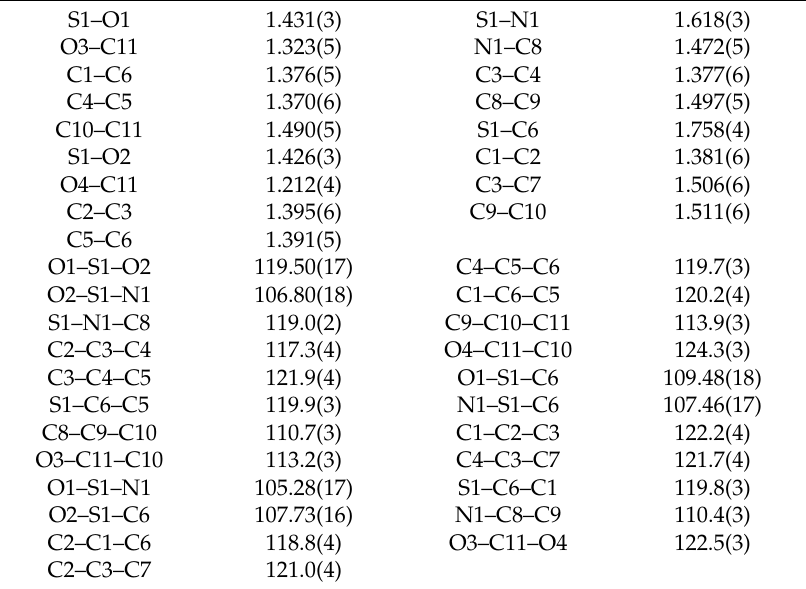
Figure 3. Atom numbering and thermal ellipsoids at a 30% probability level for 4c . Table 4. Bond lengths (Å) and angles ( ◦ ) for 4c